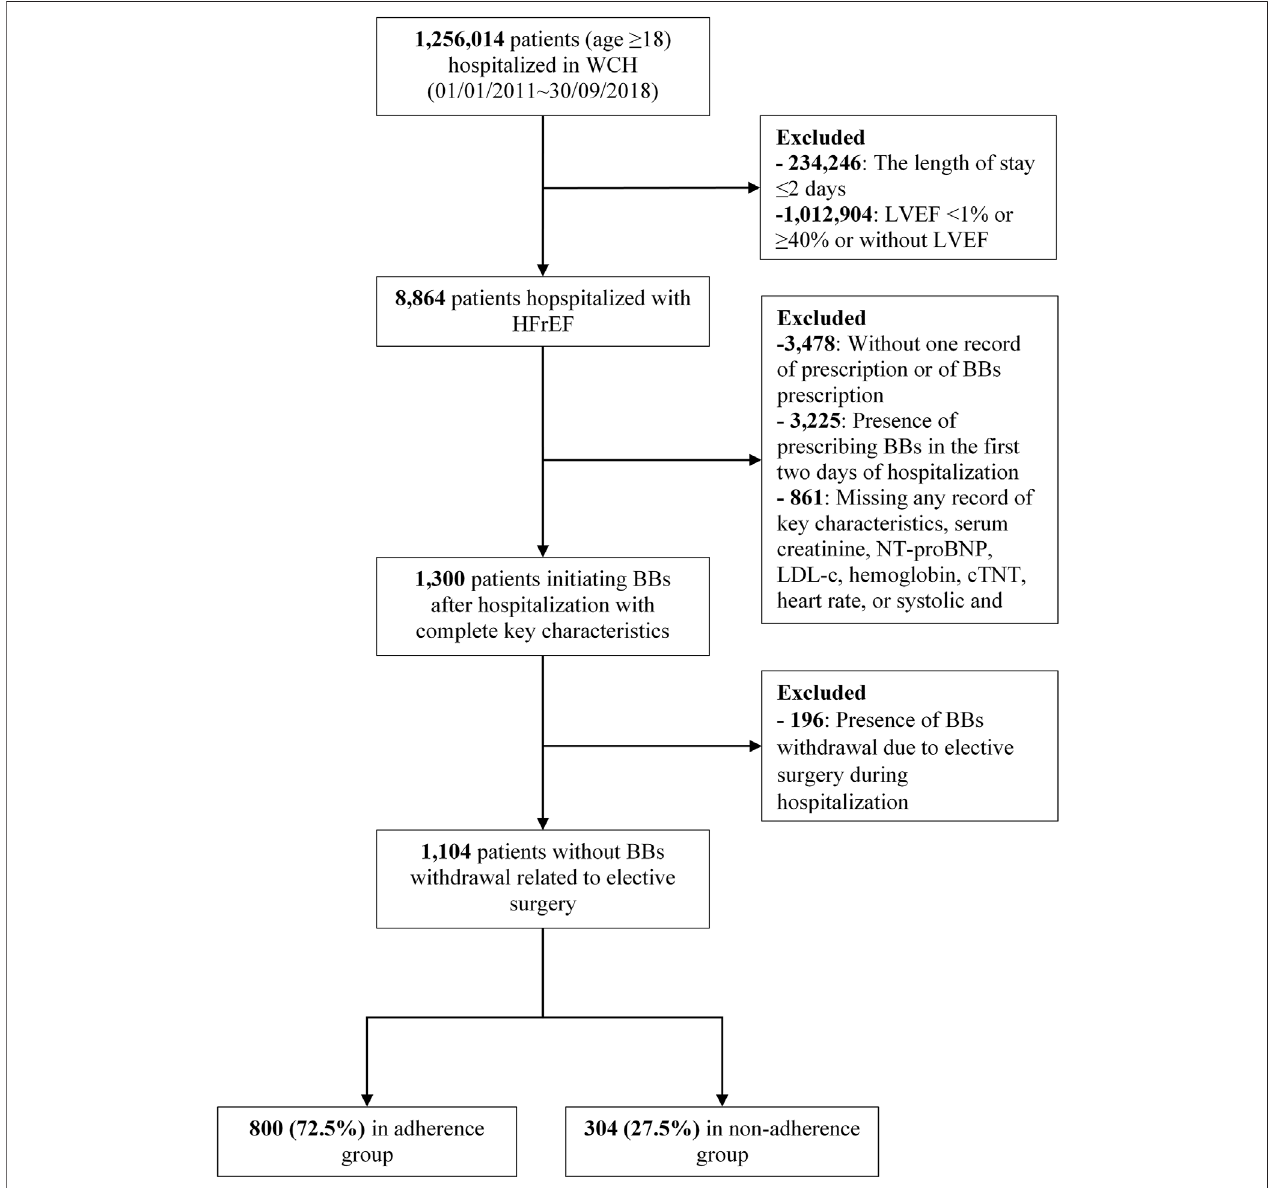
FIGURE 1 | Patient disposition.; Abbreviations: WCH, the West China Hospital of Sichuan University; BB, beta blocker; LVEF, left ventricular ejection factor; NT- proBNP, N-terminal pro-B type natriuretic peptide; LDL-c, low-density lipoprotein; cTNT, cardiac troponin T; HFrEF, heart failure with reduced ejection fraction.